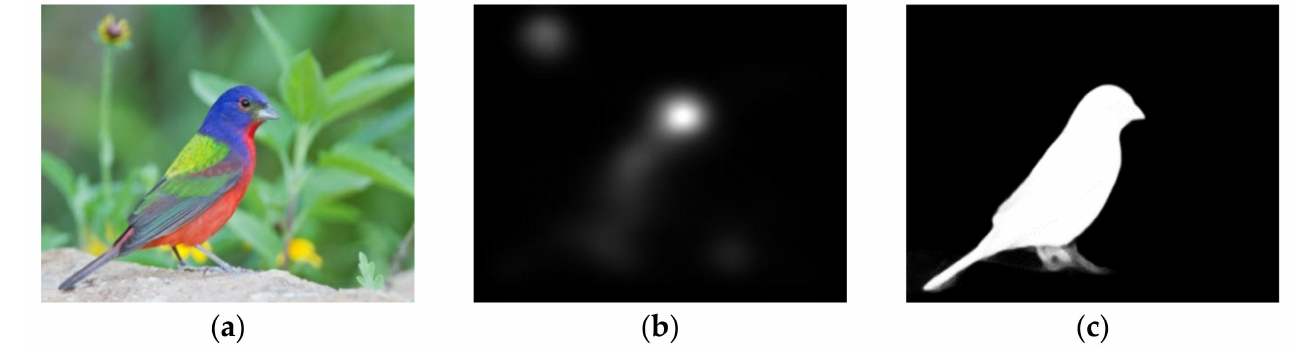
Figure 1. Two saliency detection tasks: ( a ) Original image, ( b ) Saliency prediction task, ( c ) Salient object detection